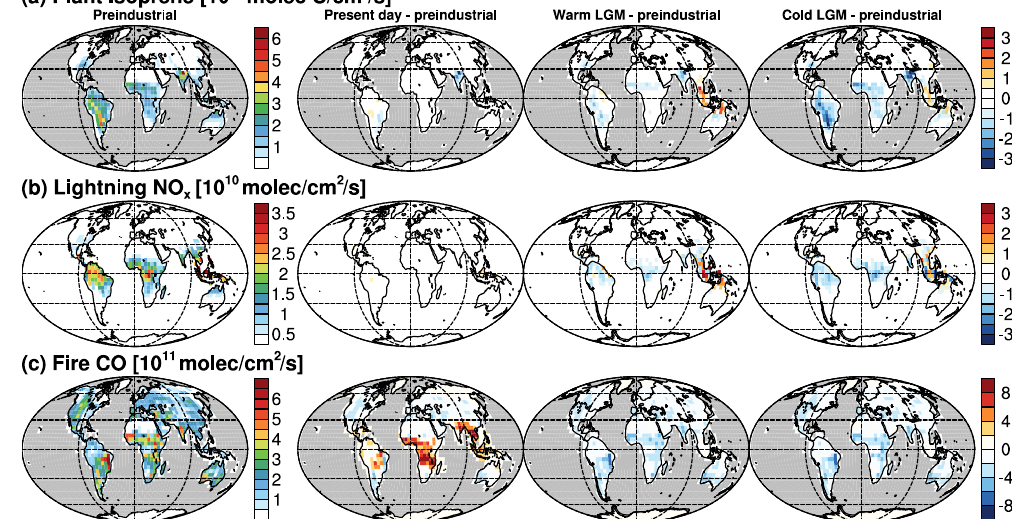
Fig. 7. Spatial distribution of annual mean preindustrial emissions, and the present-day and LGM absolute changes in these emissions relative to the preindustrial for (a) isoprene from terrestrial plants, (b) NO x from lightning, and (c) CO from fires in the low-fire scenario. The difference plots share the common color bars at right.